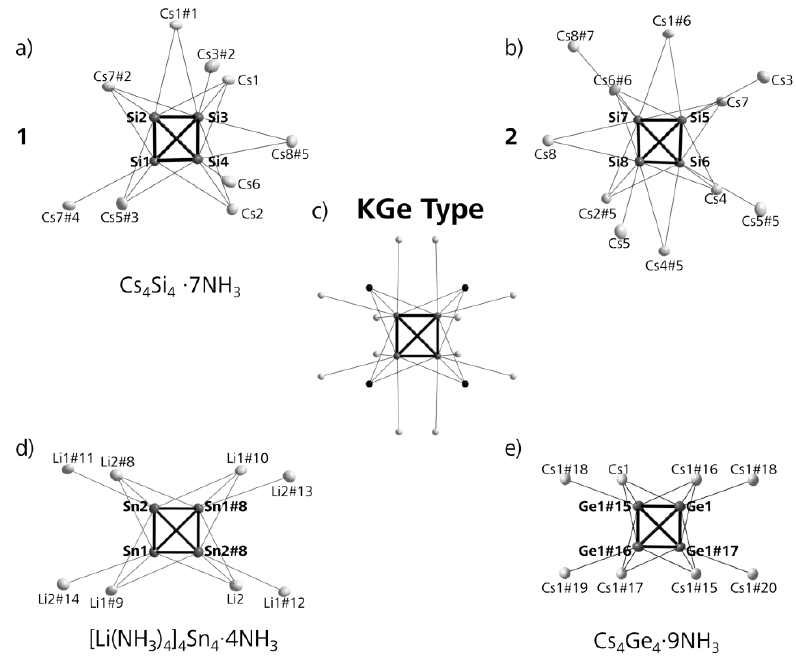
Figure 5. Comparison of the cationic coordination spheres of [E 4 ] 4− (E = Si-Sn) clusters in Cs 4 Si 4 ·7NH 3 ( a , b (two crystallographically independent [Si 4 ] 4− cages)), KGe ( c ); [Li(NH 3 ) 4 ] 4 Sn 4 ·4NH 3 ( d ) and Cs 4 Ge 4 ·9NH 3 ( e ); probability factor: 50%; dark grey marked cations occupy special Wyckoff